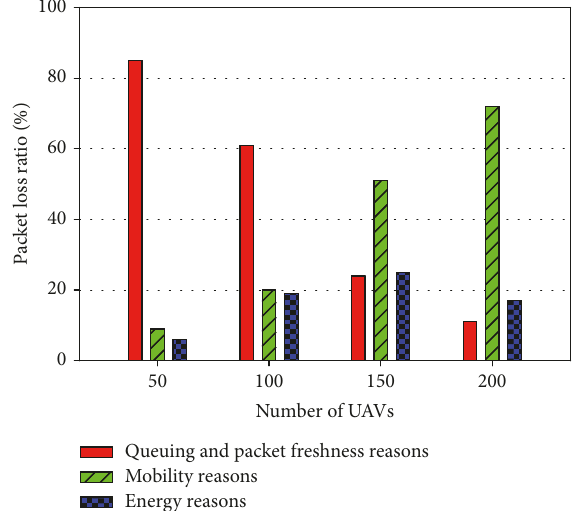
Figure 11: Reasons of unintentional dishonesty